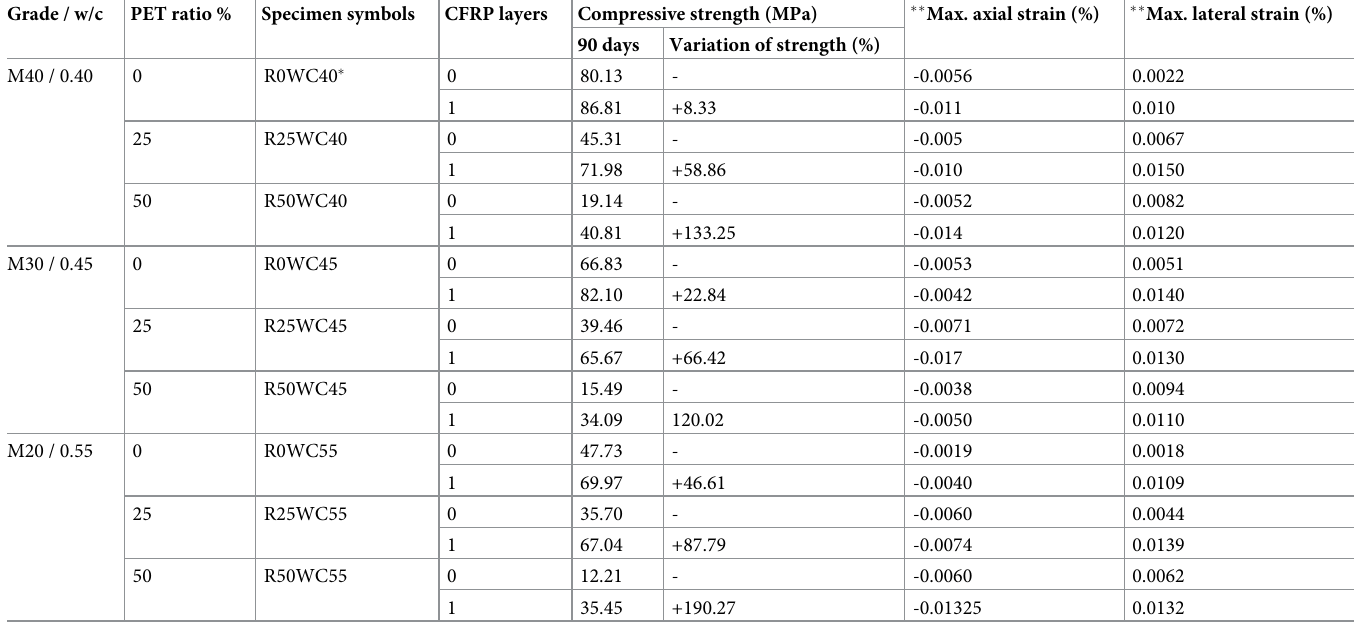
Table 9. Details of test